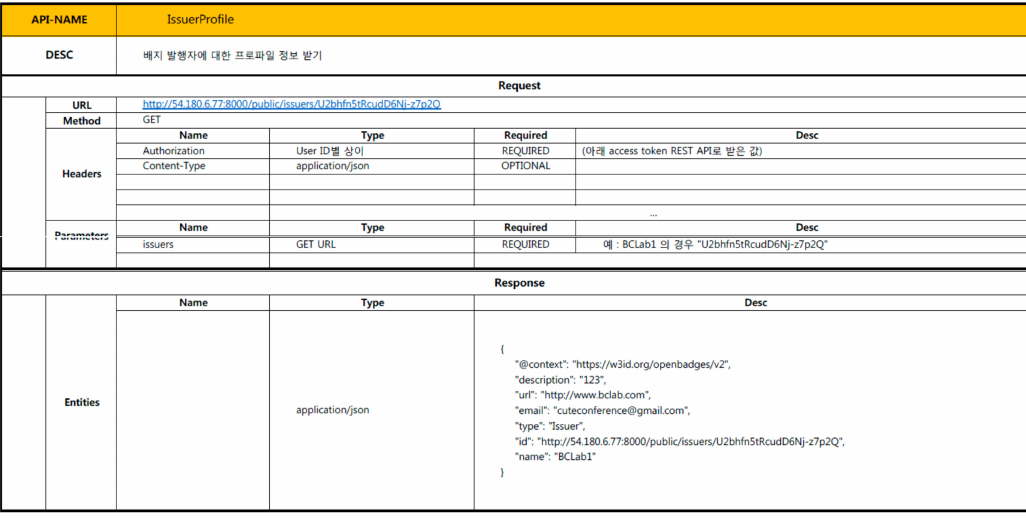
Figure 15. REST API for User Profile.